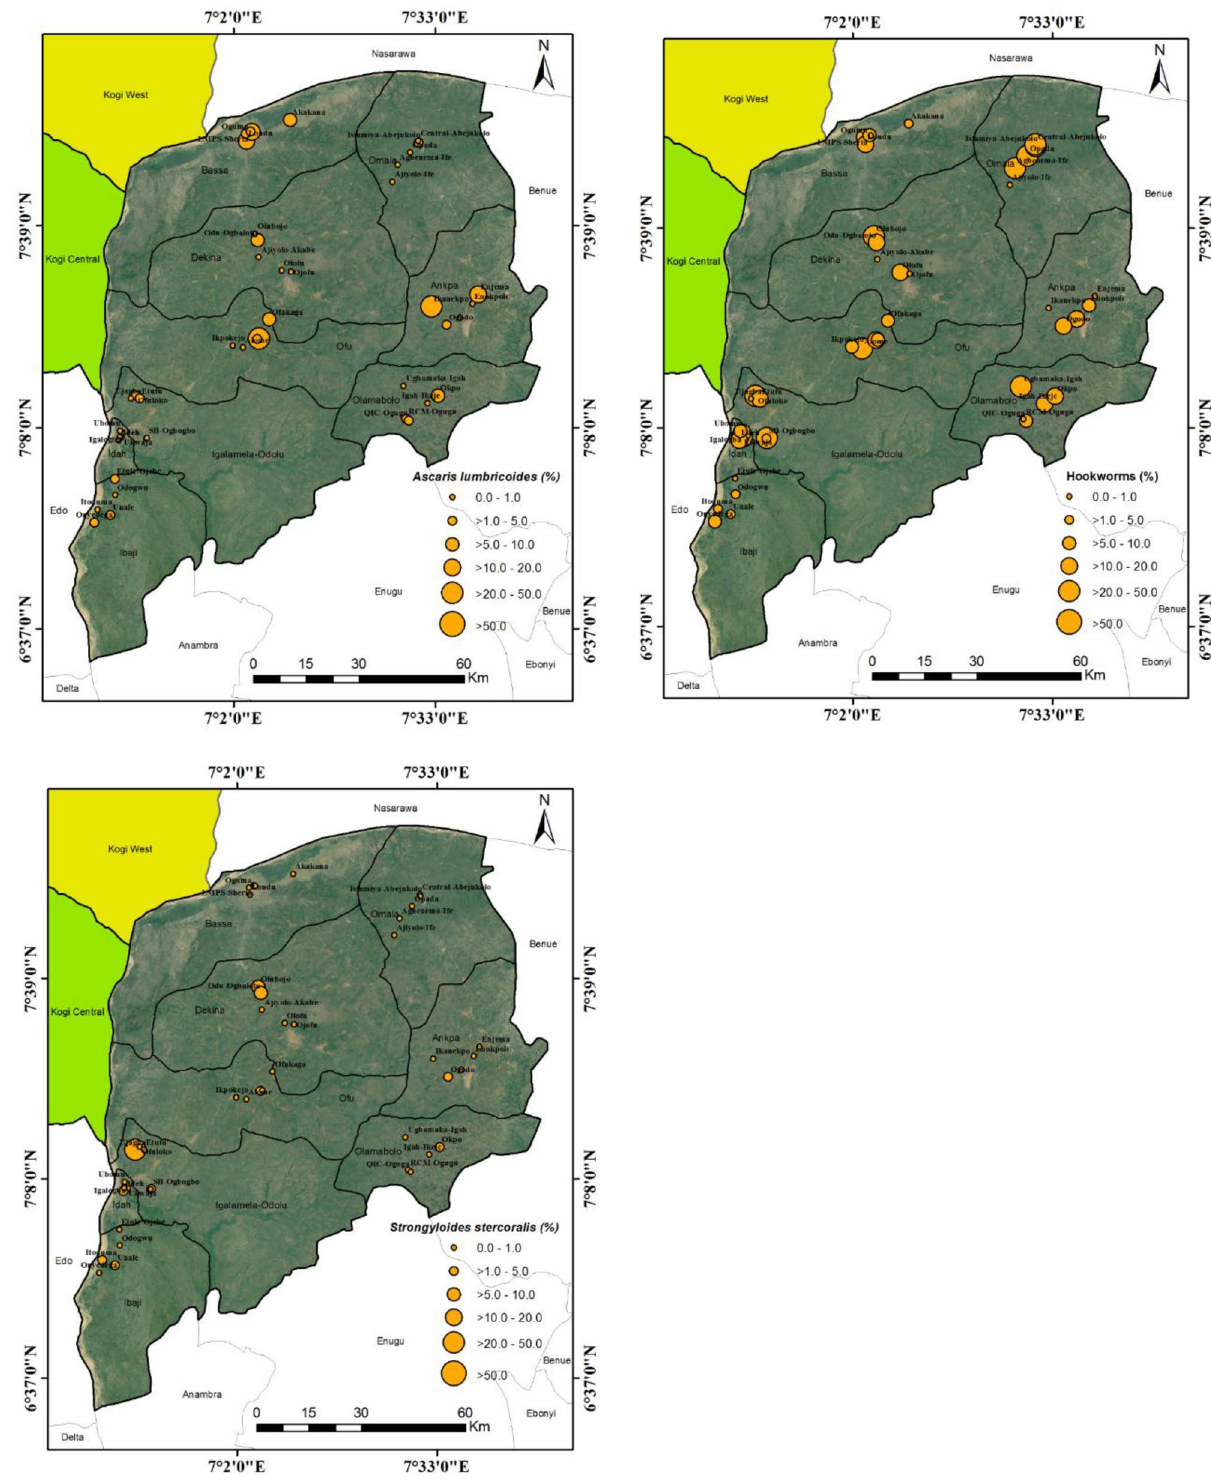
Figure 1. Spatial Distribution of STHs in Communities of Kogi East, North Central Nigeria. Source of Satellite Imagery: Image Google Earth: Landsat/Copernicus (Data SIO, NOAA, U.S. Navy, NGA, GEBCO. Maps were visualized on ArcMap 10.1. https:// www. google. com/ maps/ place/ Kogi/@7. 31959 59,7. 26328 04,18932 4m/ data= !3m1!1e3!4m5!3m4!1s0x1 04f41 e9d61 f12dd: 0xbdc 9f94f 2d58a afd!8m2!3d7. 73373 25!4d6. 69058